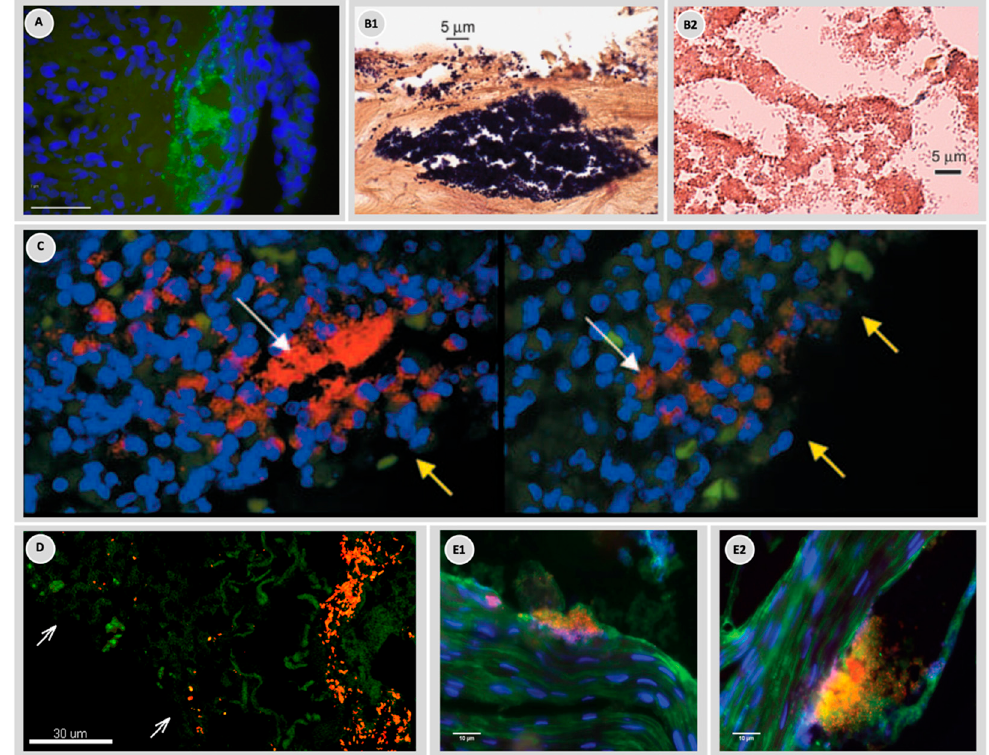
Figure 2. Visualization of bacterial biofilms in chronic wounds by different staining techniques and microscopy. ( A ) A chronic venous leg ulcer with P. aeruginosa aggregates (green) visualized by PNA fluorescence in situ hybridization (FISH) and inflammatory cells visualized by DAPI (blue) [13]. ( B1 , B2 ) Aggregates in ulcers visualized by Gram staining ( B1 ) Gram-positive cocci near the surface of a pressure ulcer and ( B2 ) Gram-negative rods in a diabetic ulcer [9]. ( C ) Visualization by PNA FISH of P. aeruginosa aggregates (red) in a chronic wound and visualization of inflammatory cells by DAPI (blue). The white arrow indicates localization of bacterial aggregates and the yellow arrow the wound surface [42]. ( D ) Aggregates of P. aeruginosa (red) and S. aureus (green) in a chronic wound visualized by PNA FISH. White arrows indicate the wound surface [40]. ( E1 , E2 ) Aggregates in chronic diabetic foot wounds visualized by a combination of FISH and Concanavalin A-conjugated Alexa Fluor 488 that binds to the biofilm matrix [43].